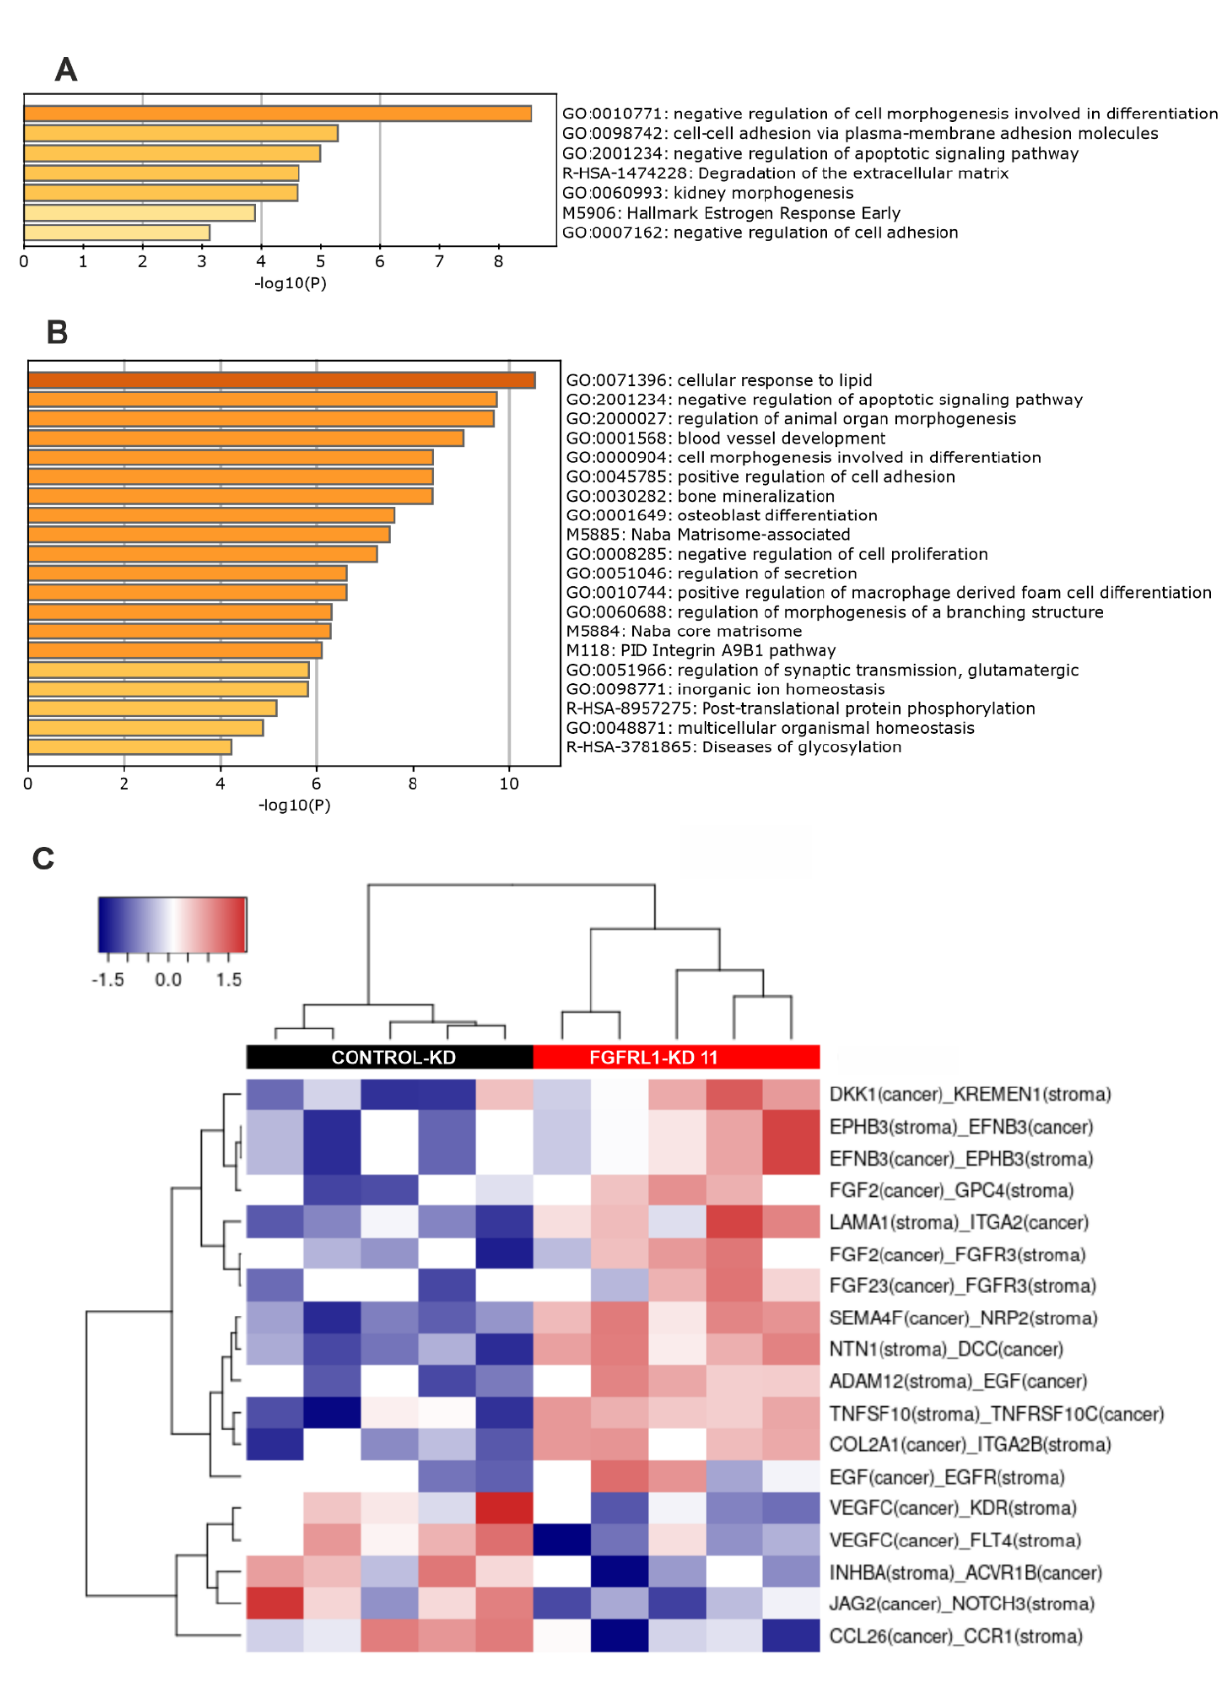
Figure 6. Bioinformatic analyses of differentially expressed (DE) genes in PC3M cell line and mouse xenografts. ( A ) Significantly enriched gene ontology (GO) categories and pathways in 71 DE genes identified in both PC3M cells and the mouse xenograft tumors, after FGFRL1 knockdown. Genes were analyzed by gene set enrichment analyses (GSEA) in the MSigDb database (http://www.gsea- msigdb.org, 10 January 2021) and visualized using Metascape (www.metascape.org, 15 January 2021). ( B ) Enriched GO categories and pathways in DE gene set (100 genes up and 100 genes down) identified in FGFRL1-KD xenograft tumors using GSEA and Metascape for visualization. ( C ) Heat map indicating significantly enriched tumor–stroma interactions detected by the CASTIN algorithm in FGFRL1-KD xenografts compared to controls [40]. Stroma: corresponds to reads matched to the mouse genome (= mouse stromal cells in xenografts). Tumor: corresponds to reads matched to human genome (= PC3M cells in xenografts).